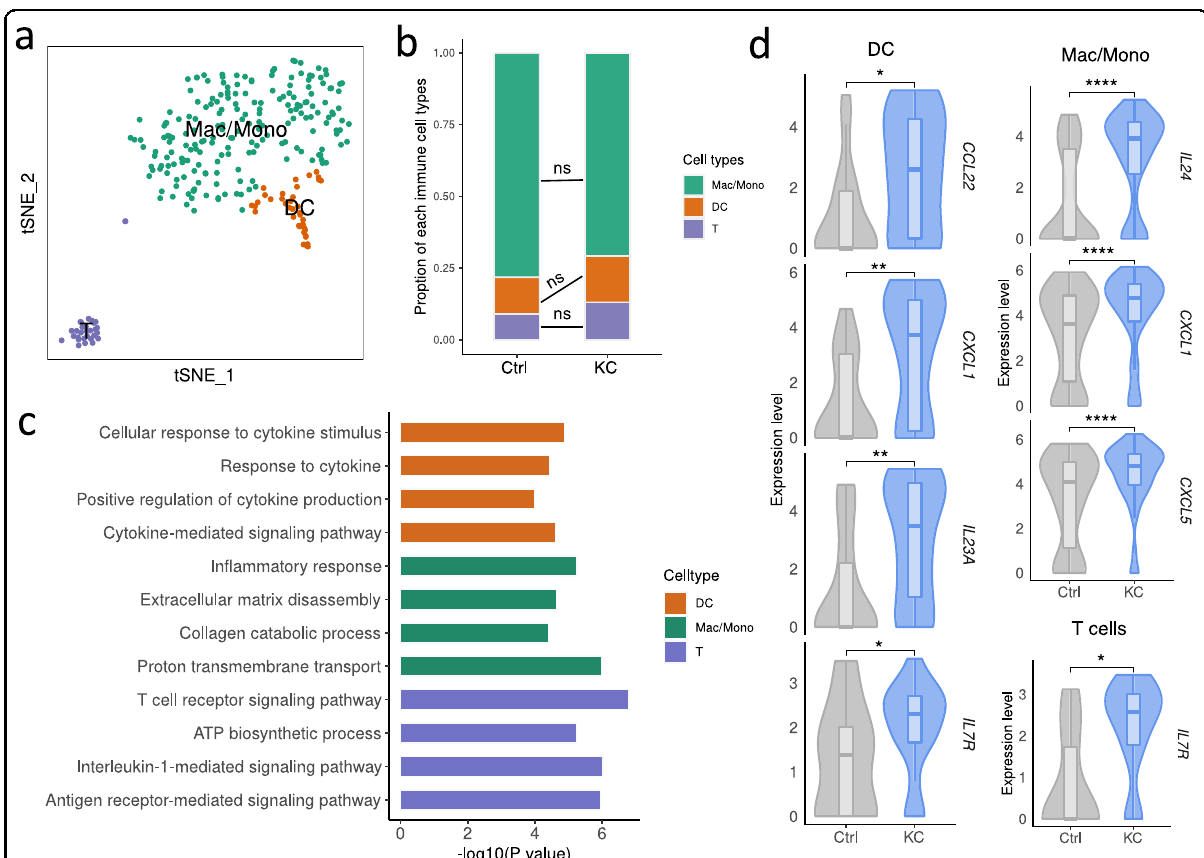
Fig. 5 In fl ammatory signals in keratoconus corneas contributed by immune cells. a t-SNE plot showing three immune cell types identi fi ed in KC and Ctrl samples. b Proportion of each immune cell type in KC and Ctrl samples. ns, no signi fi cance (Student ’ s t -test). c Representative GO terms of keratoconus-upregulated genes in each immune cell type. d Violin plots showing representative differentially expressed cytokines in keratoconus immune cells. * P < 0.05, ** P < 0.001, **** P < 0.0001 (two-sided Wilcoxon rank-sum